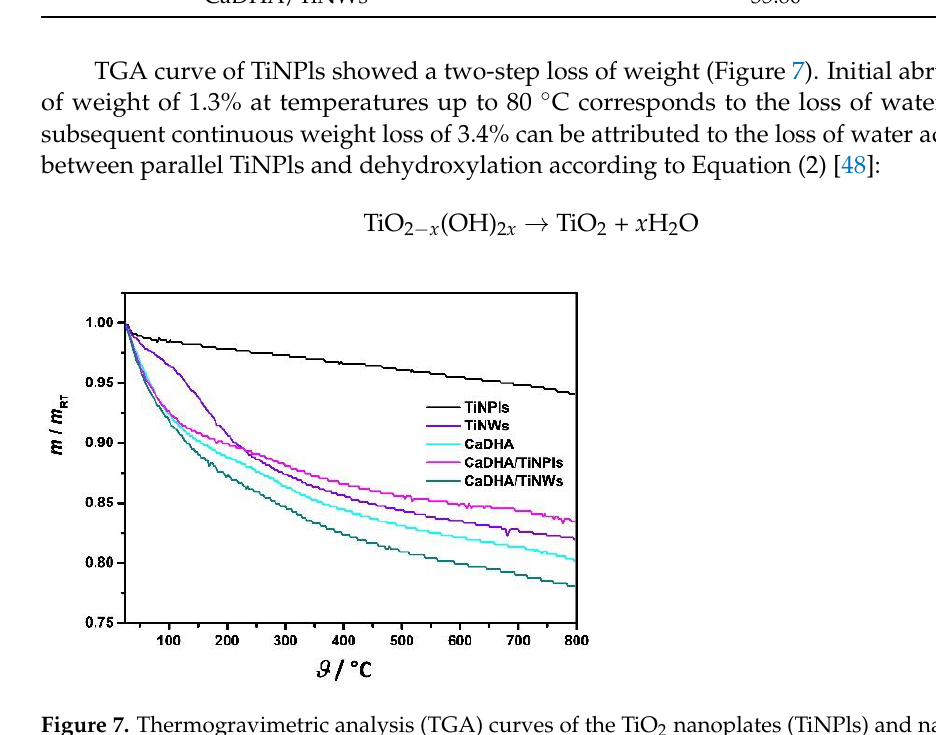
Figure 7. Thermogravimetric analysis (TGA) curves of the TiO 2 nanoplates (TiNPls) and nanowires (TiNWs), precipitates formed after 60 min reaction time in the control system (calcium deficient hydroxyapatite, CaDHA [13]) and in the presence of 100 mg L − 1 TiO 2 nanoplates (CaDHA/TiNPls) and nanowires (CaDHA/TiNWs). c (CaCl 2 ) = c (Na 2 HPO 4 ) = 4 · 10 − 3 mol dm − 3 , pH init = 7.4, ϑ = (25 ± 0.1) °C.